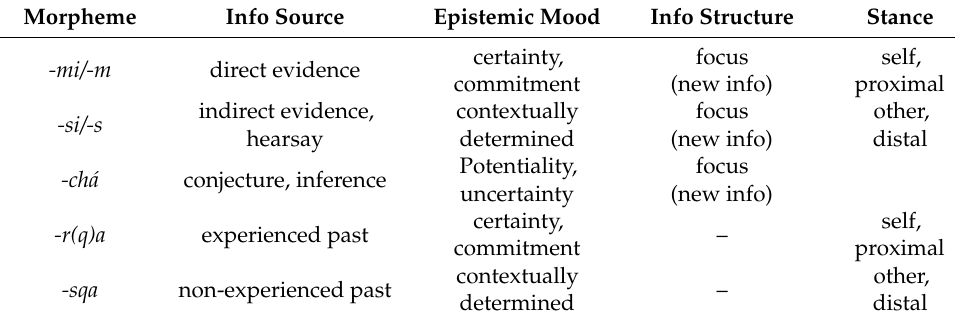
Table 1. Pragmatic values of evidential enclitics and past tense suffixes in